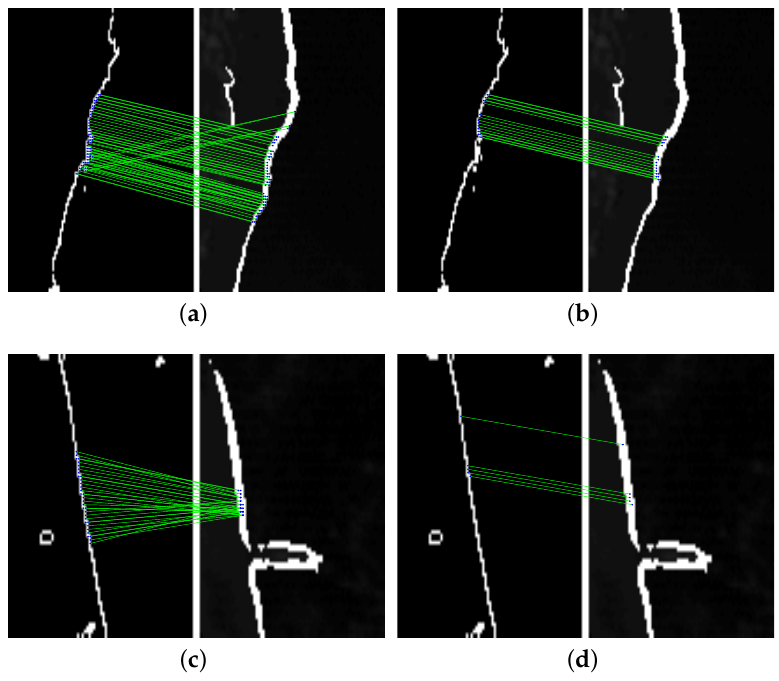
Figure 3. The details of the initial matching and feature refinement in the southern coastal area of Thailand. ( a ) initial matching; ( b ) feature refinement; ( c ) initial matching; and ( d ) feature